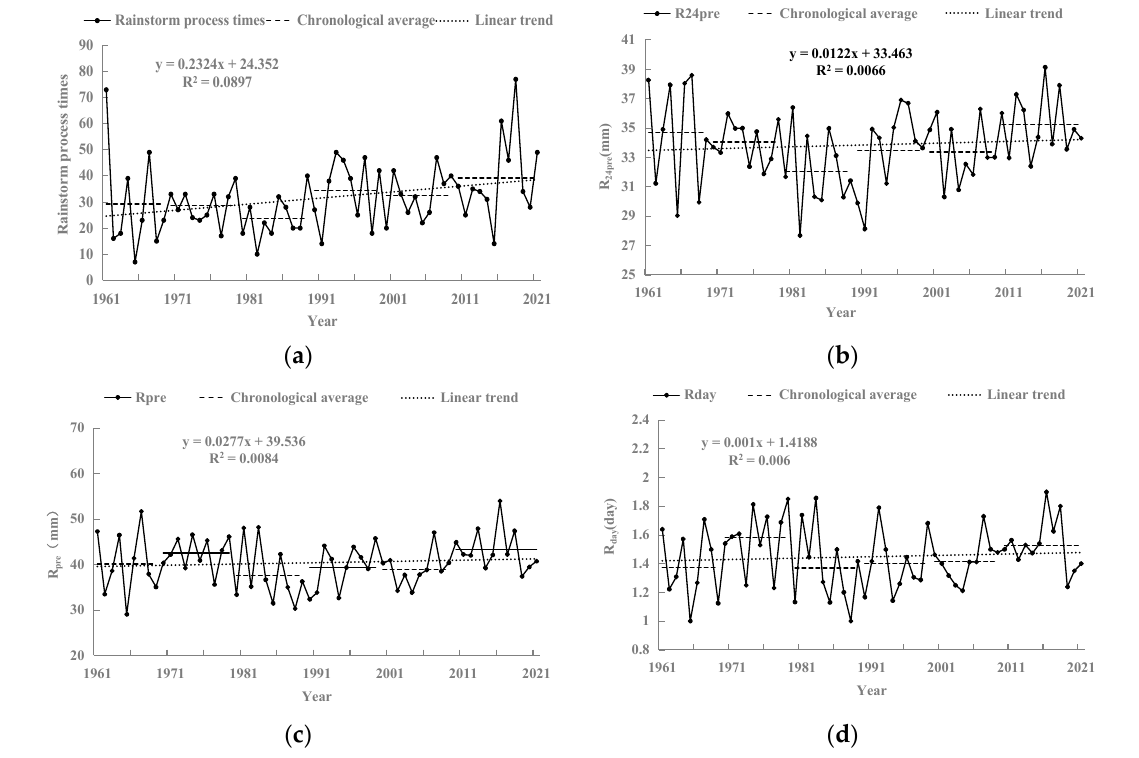
Figure 4. Variation curves of the number of rainstorm processes ( a ), maximum daily precipitation ( b ), accumulated precipitation ( c ), and duration of precipitation ( d ) in the upstream of Yellow River Basin from 1961 to 2021.